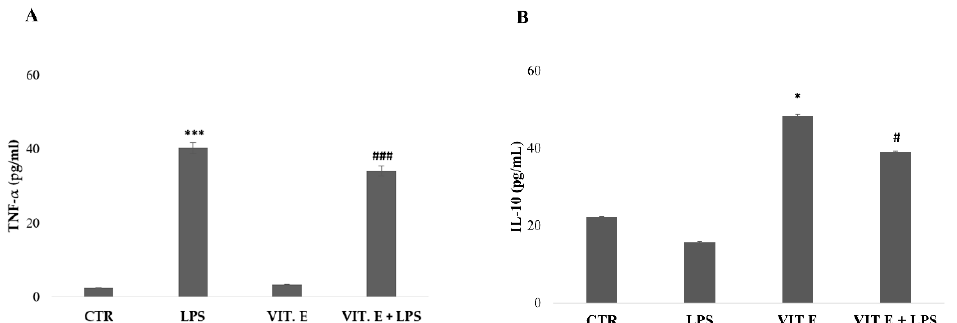
Figure 4. Evaluation of cytokine concentrations following administration of vitamin E with or without LPS. Analysis of cytokine concentrations (TNF- α ( A ) and IL-10 ( B )) with stimulation of 100 µM vitamin E with or without LPS (1 µg/mL). Data are expressed as means (pg/mL) ± SDs. ( A ) *** p < 0.001 compared to the control condition. ### p < 0.001 compared to the condition of LPS-stimulated microglia. ( B ) * p < 0.05 compared to the CTR. # p < 0.05 compared to the LPS condition.